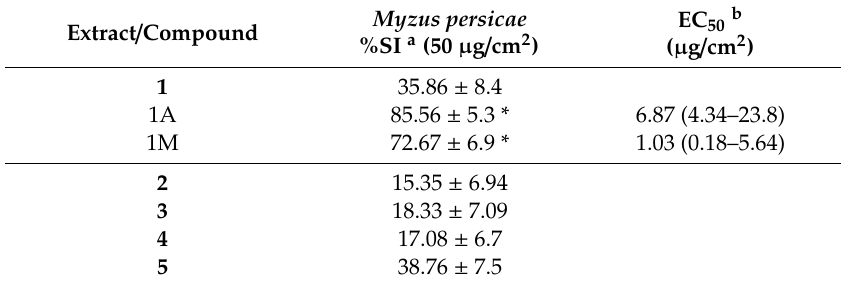
Table 4. Antifeedant e ff ects of mixture 1, the free fatty acids from the hydrolysis of mixture 1 (1A), their methylated esters (1M) and compounds 2 – 5 on Myzus persicae .